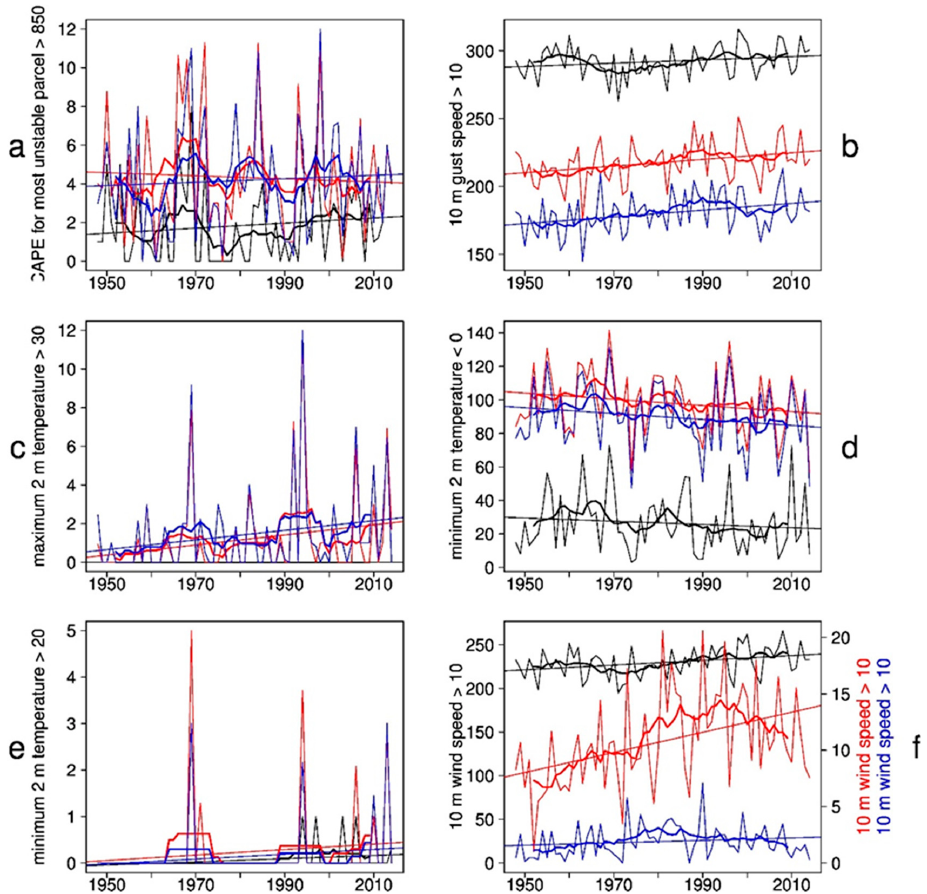
Figure 9. GB0028 time series of annual numbers of days over the North Sea (black), in the city Schwerin (red) and in the city of Hamburg (blue) with ( a ) CAPE higher than 850 J/kg, ( b ) 10 m gust speed higher than 10 m/s, ( c ) maximum 2 m temperature higher than 30 °C (hot days), ( d ) minimum 2 m temperature lower than 0 °C (frost days), ( e ) minimum 2 m temperature higher than 20 °C (tropical nights), ( f ) 10 m wind speed higher than 10 m/s.